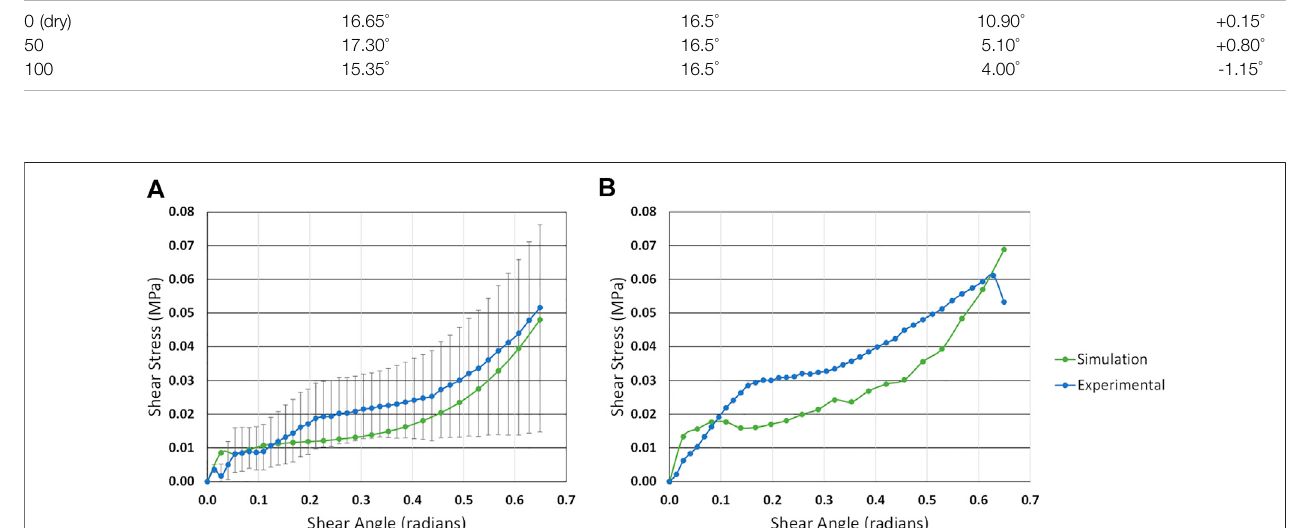
FIGURE 12 | Comparison of experimental and simulated results for (A) 50% and (B) 100% coverage at 12 mm/s crosshead displacement rate.